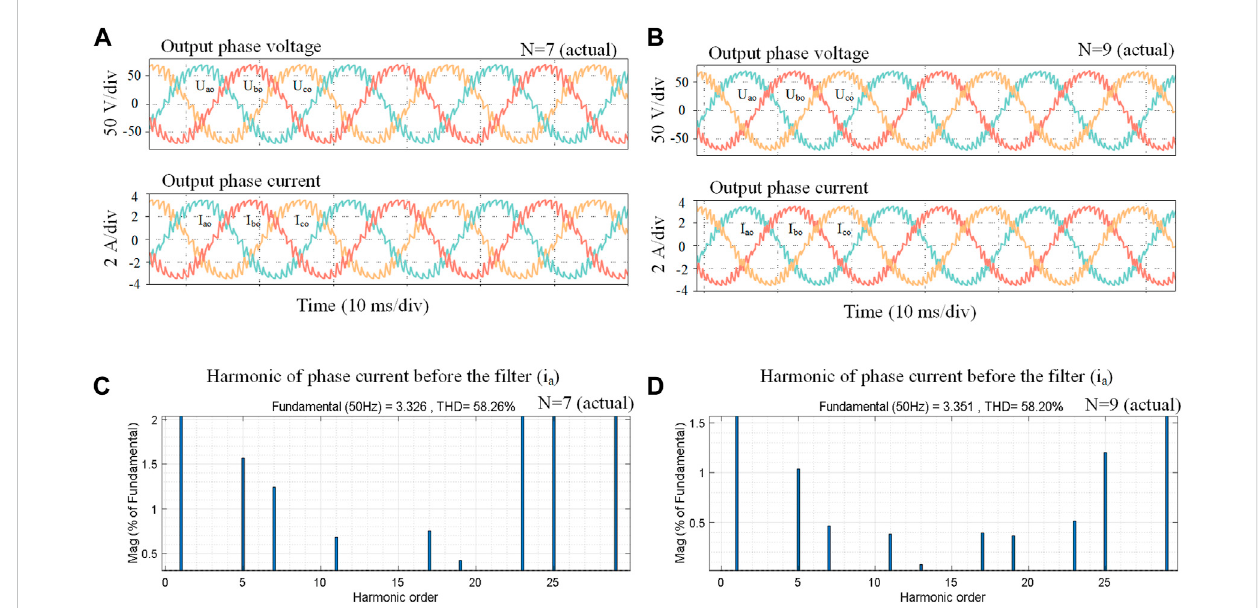
while reducing switching loss. Available choices are high-speed RB- IGBT, or SiC MOSFET with Diode, etc. The reverse-blocking capability can be realized via series connected power diodes. Compared with the conventional all-hardware-update routine